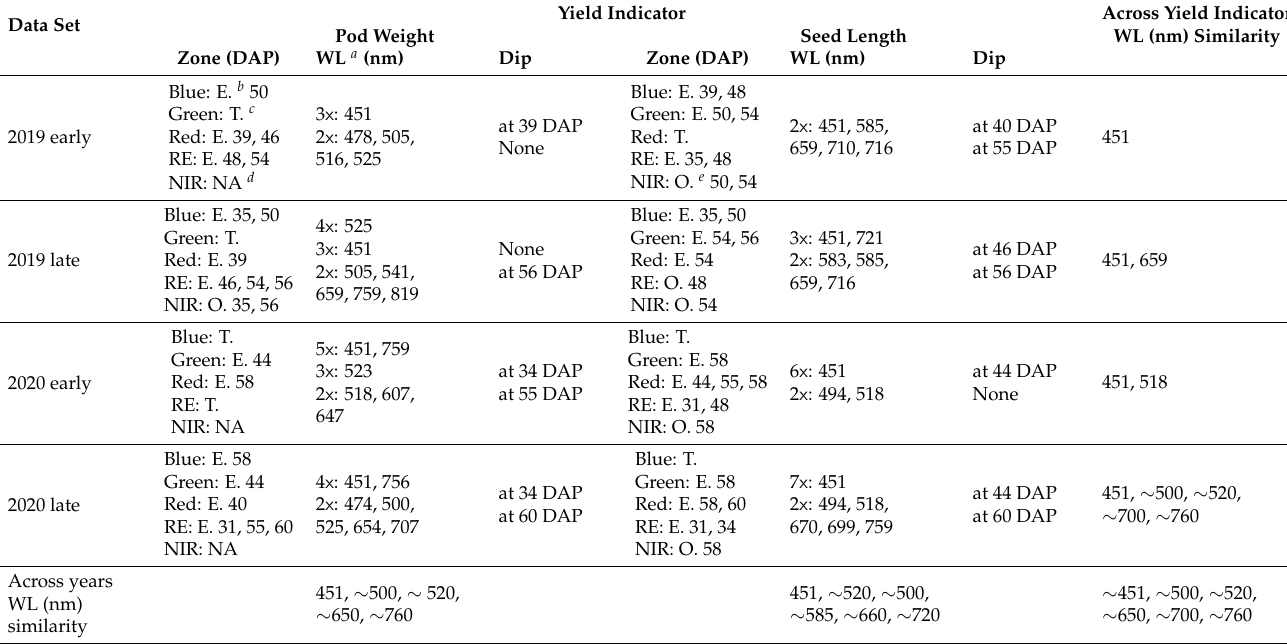
WL (nm) SimilarityPod Weight Seed Length